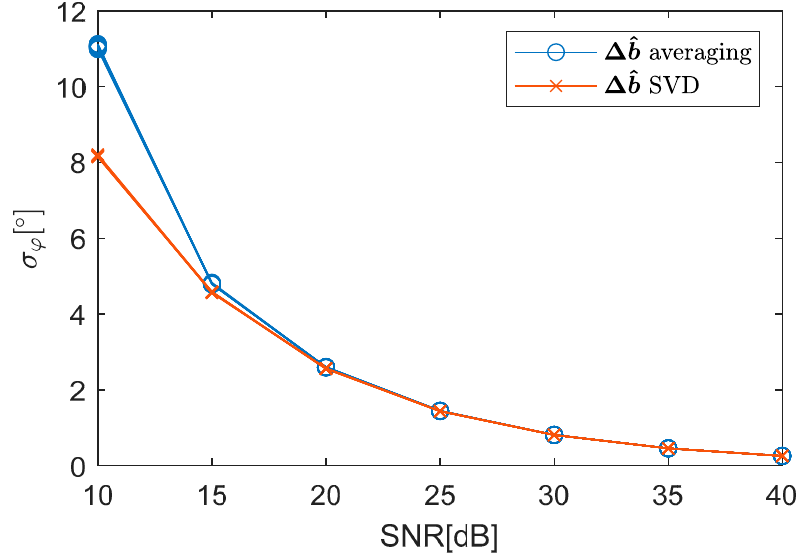
Figure 7. The standard deviation of phase for coefficients of vector Δ𝒃(cid:3553) .